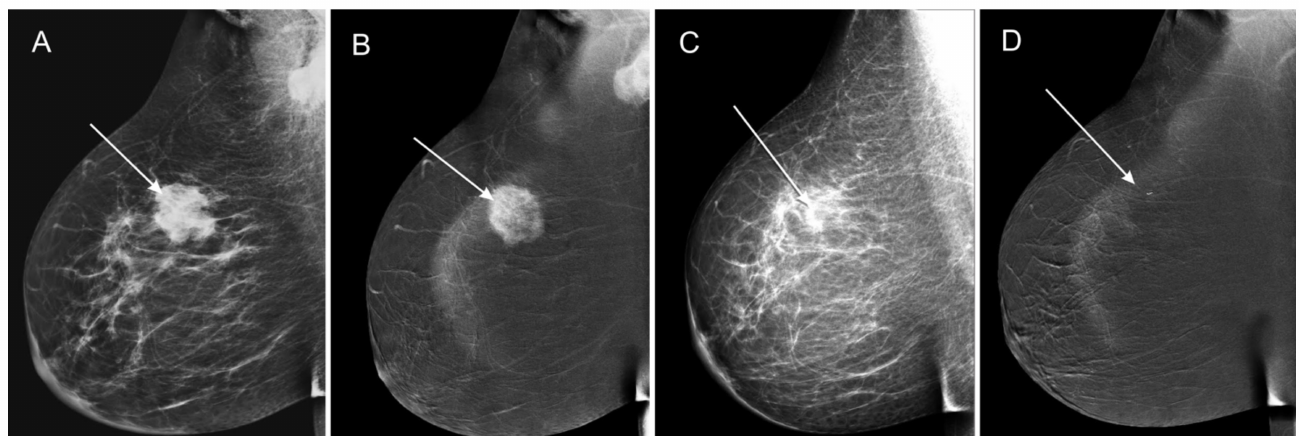
Figure 4. Assessment of therapeutic response in low-energy MLO ( A , C ) and subtraction MLO ( B , D ). Before NAC, a tumor can be seen in the upper outer quadrant of the right breast with high density and polycyclic outlines, accompanied by enlarged lymph nodes in the axillary fossa ( A ), revealing pathological contrast enhancement in subtraction CESM images ( B ). Following NAC, in the tumor field, there is a visible focal asymmetry, with a density lower than the residual glandular tissue ( C ), without pathological contrast enhancement ( D ). Based on the low-energy images, the therapeutic response was classified as partial response (PR). Based on the subtraction images, the therapeutic response was classified as complete response (CR), which was acknowledged in the HP